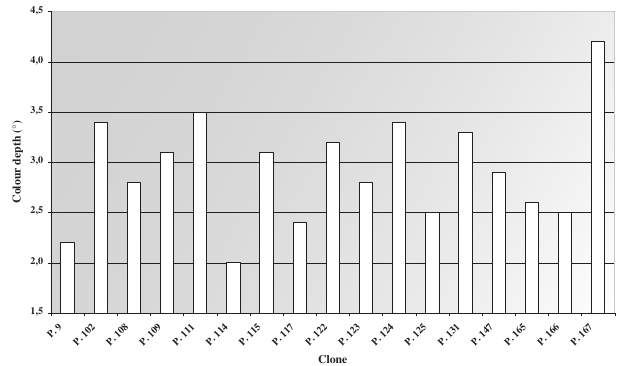
Figure 7. Colour depth of the selected ‘Kadarka’ clones (Szekszárd, Batti field – vintage of 2011)